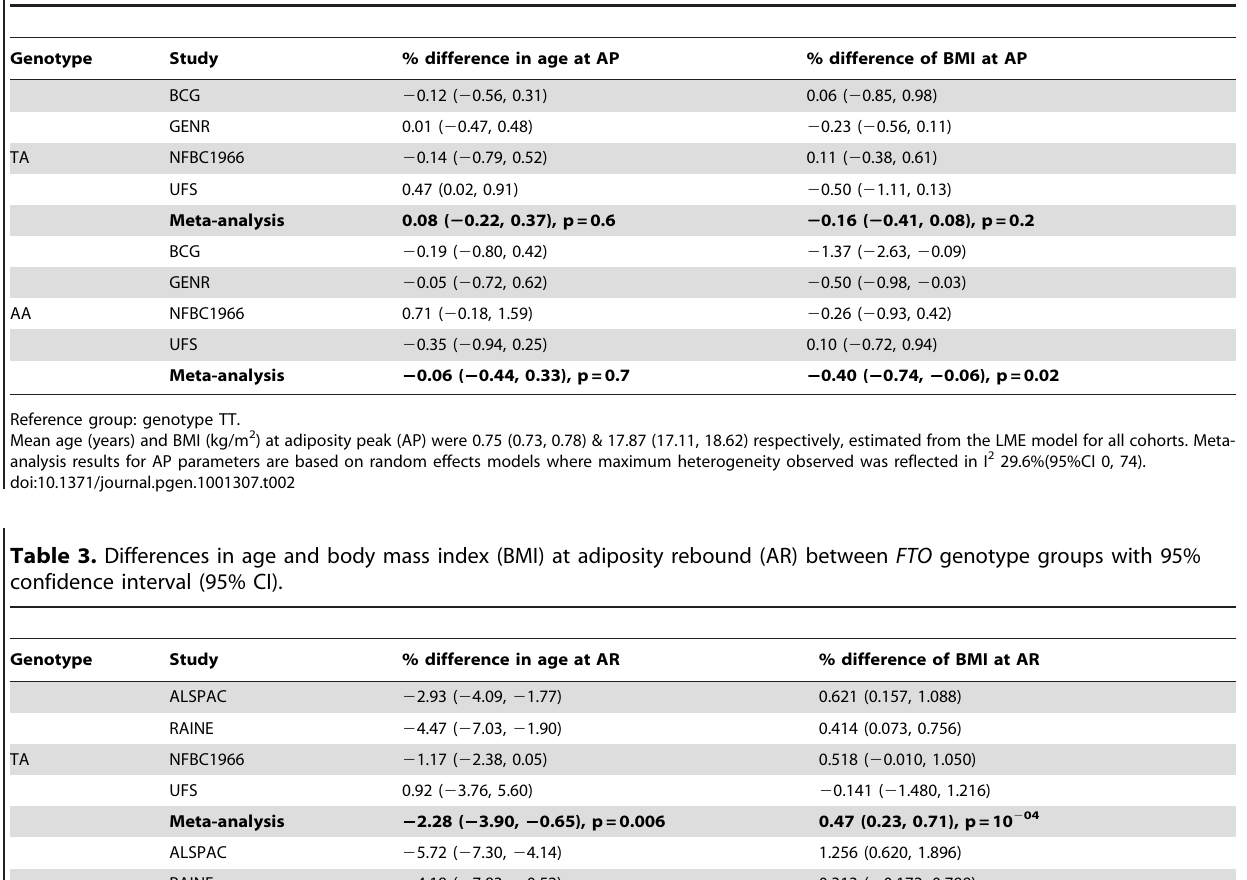
Figure 4. Estimation of the optimal age scaling effect per minor A allele for BMI. Minimum deviance corresponds to a scale factor of 2.4% (above), and adjusting for this factor synchronises the ages at adiposity rebound by genotype (below).